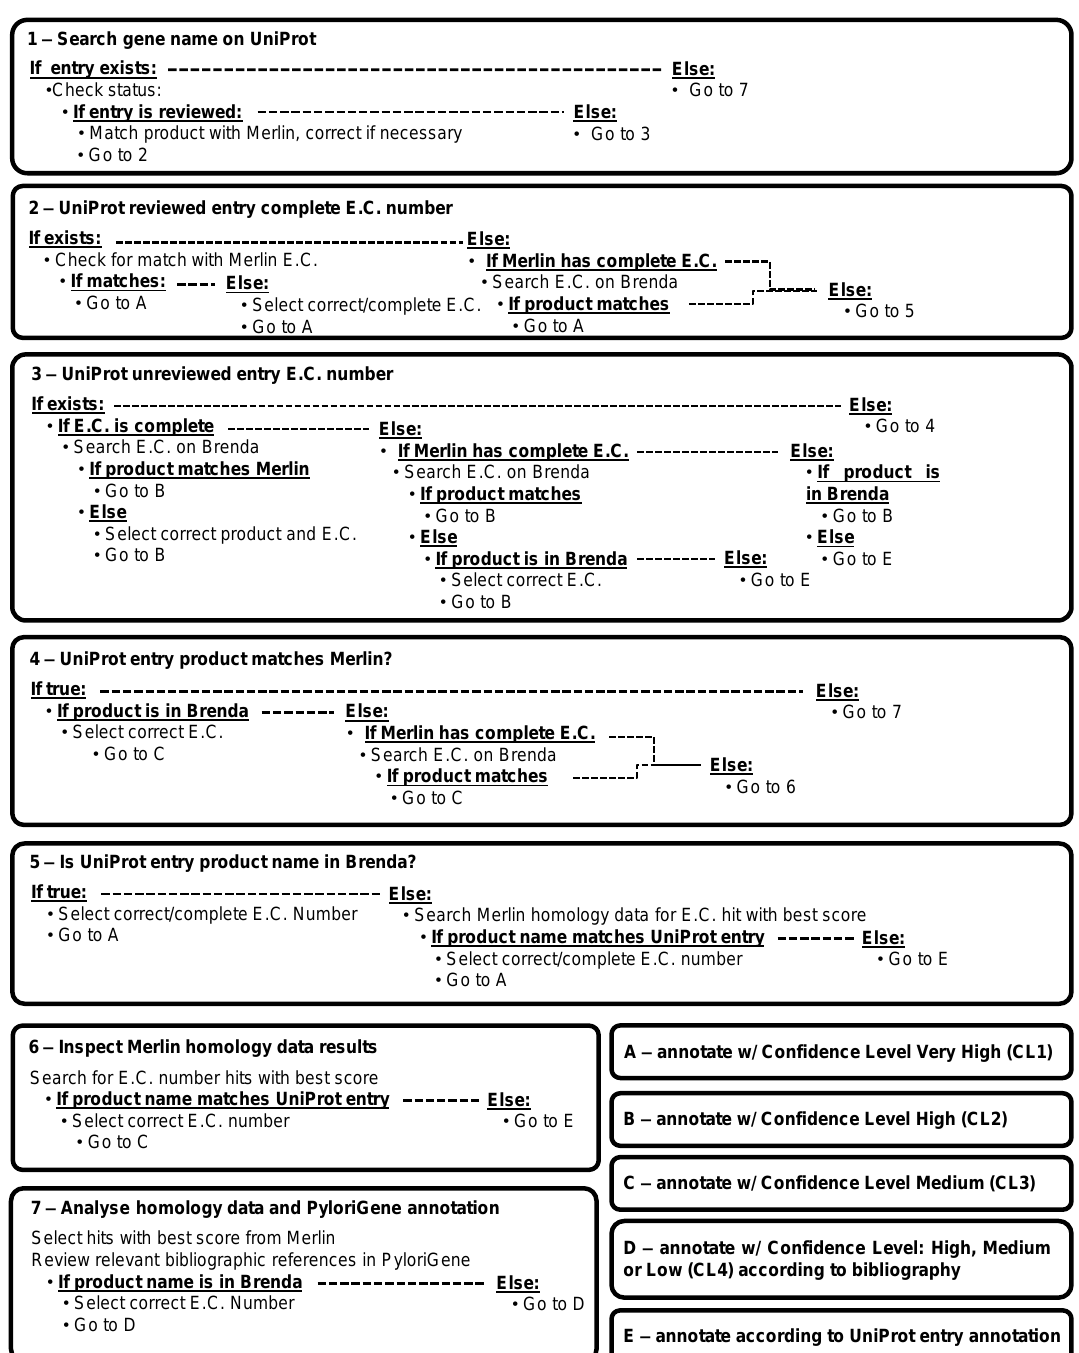
Figure 1: Re-annotation pipeline for manual inspection of each gene